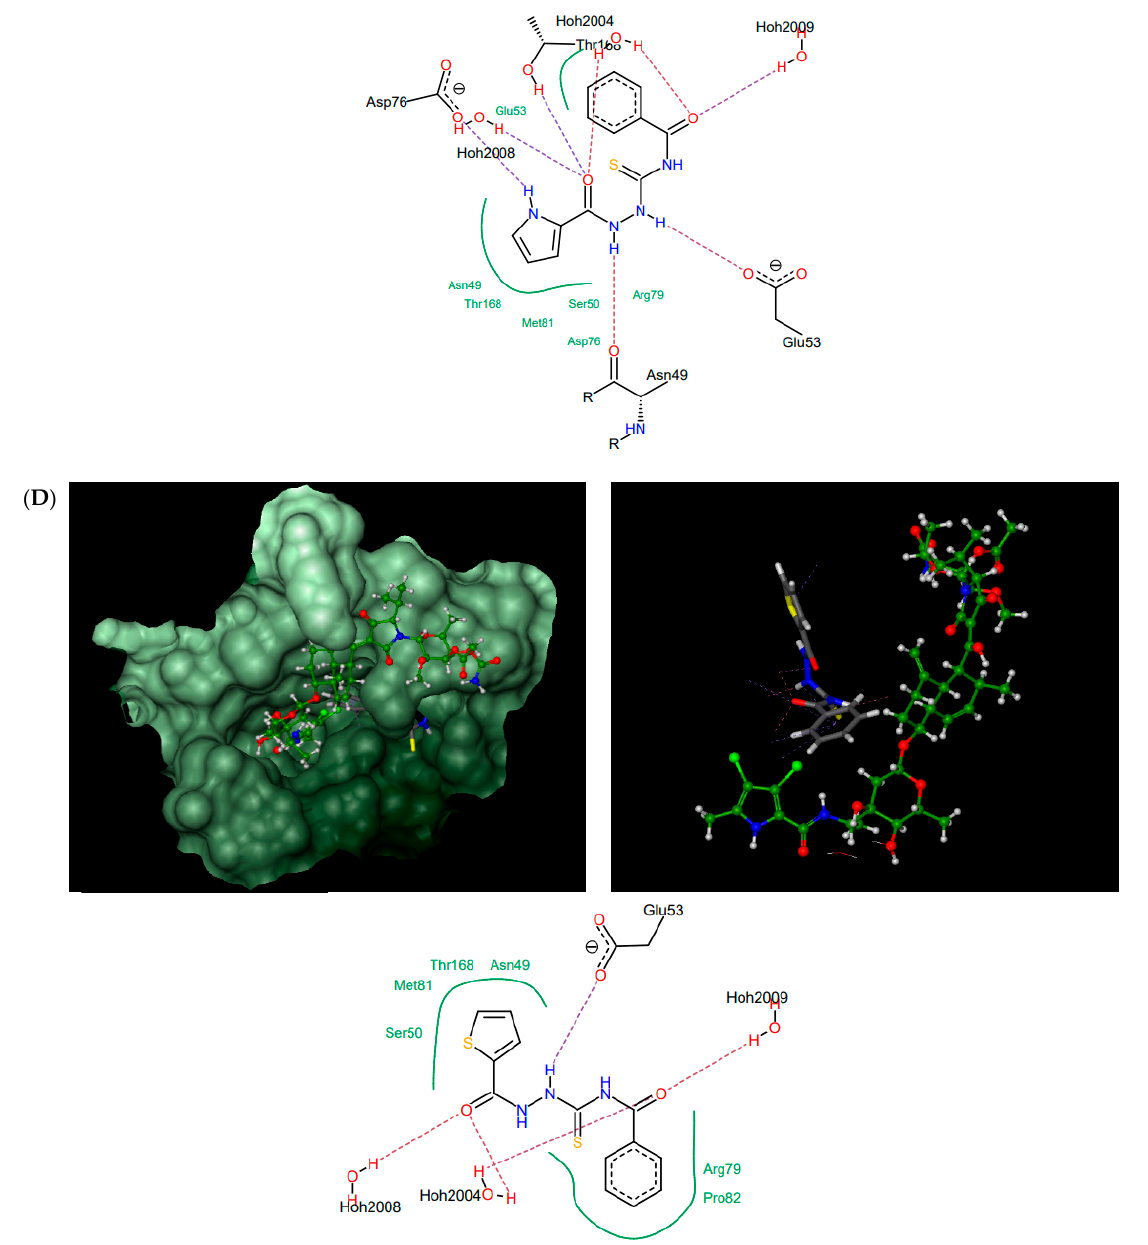
Figure 4. Thiosemicarbazides 8 ( A ), 3 ( B ), 6 ( C ), and 1 ( D ): best poses in binding to the ATP binding pocket of S. aureus 43 kDa ParE (PDB entry: 4URL) (left), best poses (in grey) overlaid with kibdelomycin (in green) (right), and interactions with amino acids in the active site (middle). With the exception of 2 , the remaining thiosemicarbazides are predicted to bind in a similar manner to 8 , both in their extended ( 3, 5, 7 ) or U-shaped ( 4 ) conformations. The binding mode of 2 is closely similar to 3 .